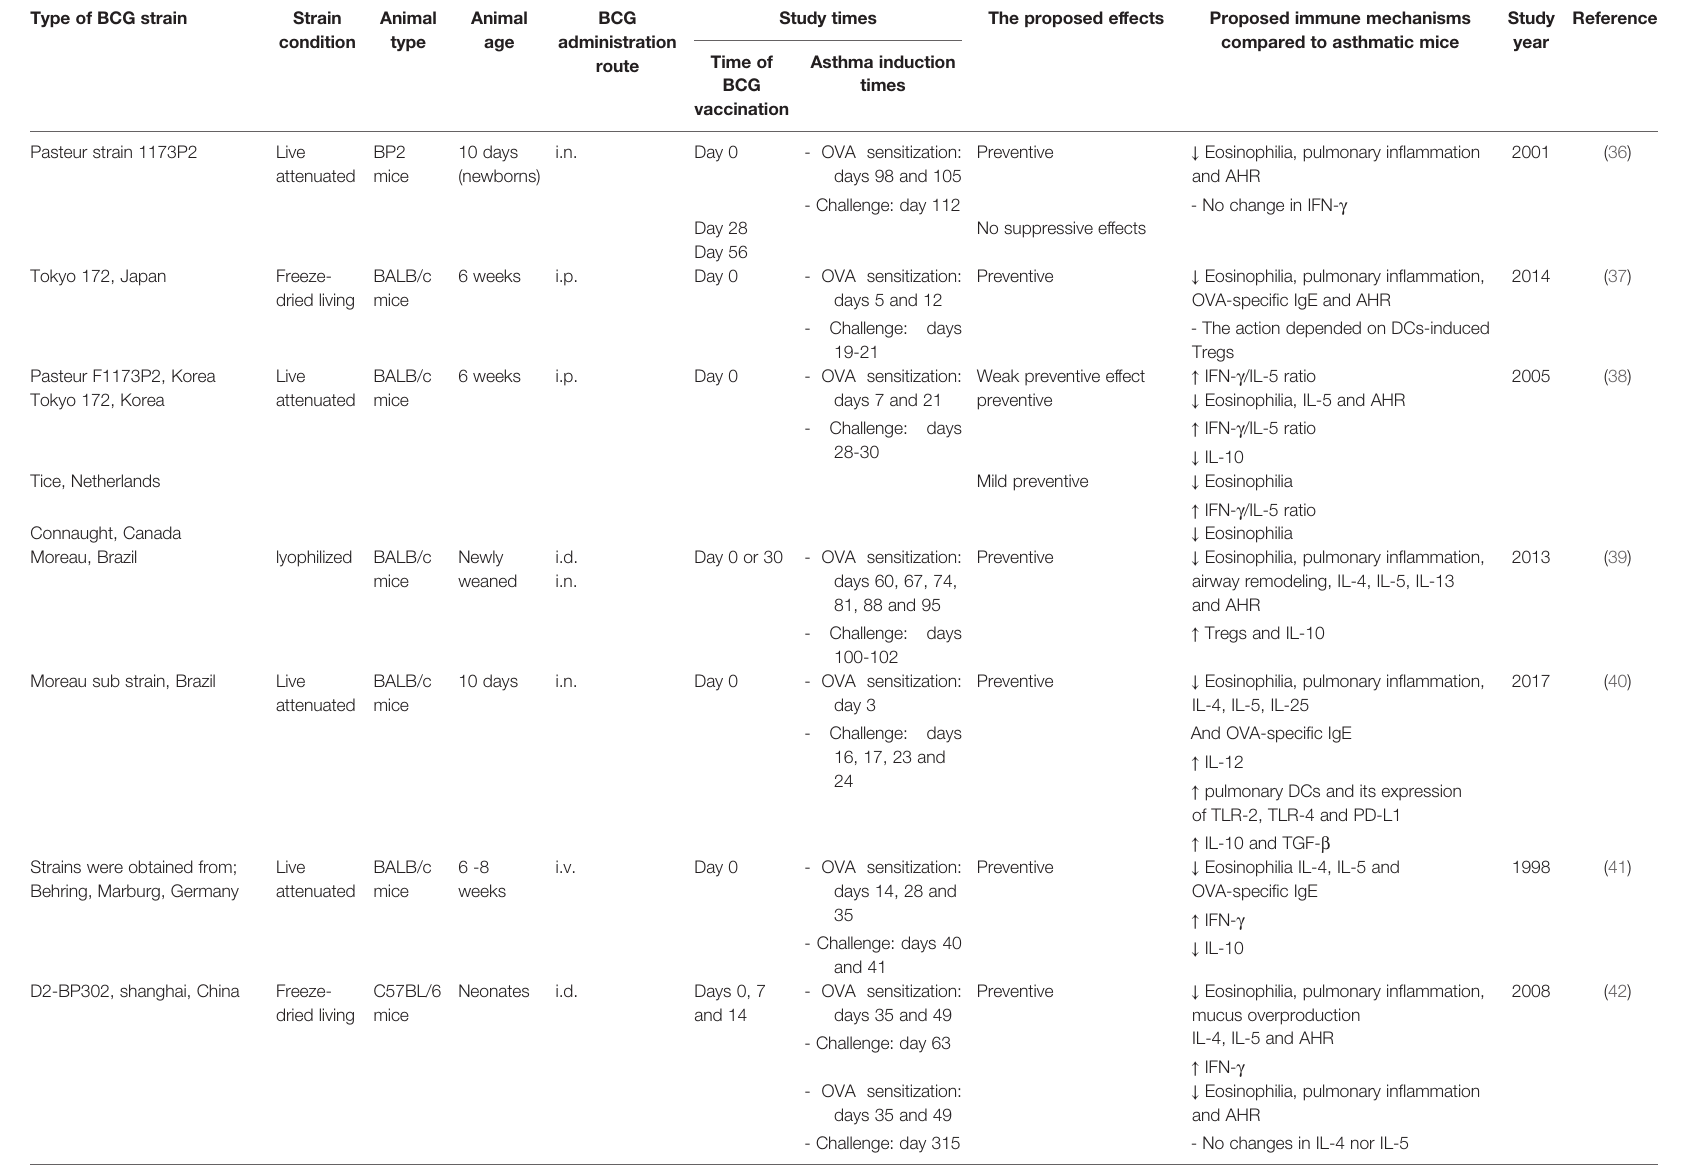
TABLE 1 | Impact of BCG vaccination on experimental murine allergic